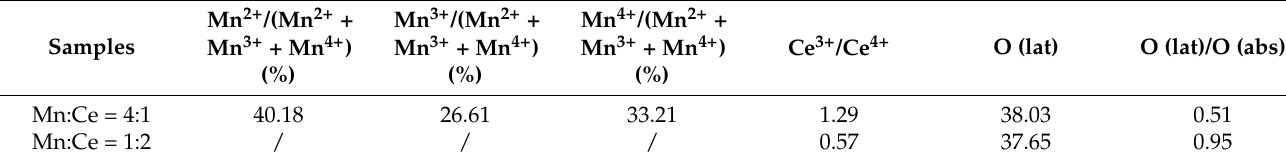
Table 3. Distribution of Mn ions, Ce ions, and O species of synthesis catalysts based on XPS results.